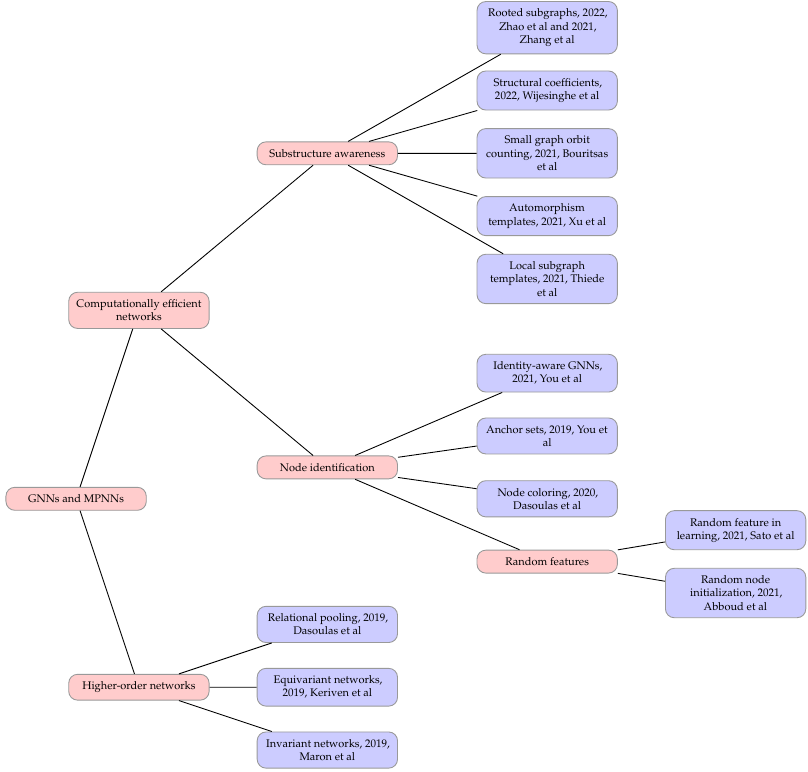
Figure 1. Overview of mathematically expressive GNNs. Red boxes refer to sections of the paper; and blue boxes represent ideas introduced by specific papers [9–22].